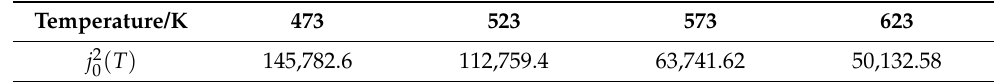
( T ) at different temperatures. Table 3. Values of j 2 0 Table 3. Values of 𝑗 02 (𝑇) at different temperatures.